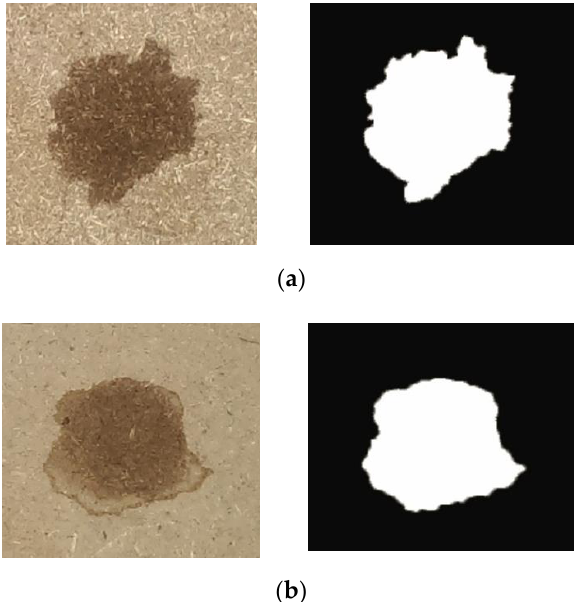
Figure 1. Photo at a constant distance from the wetted spot and the counterpart negative im- age of the same specimen in black-and-white in particleboard ( a ) and medium-density fiberboard ( b )